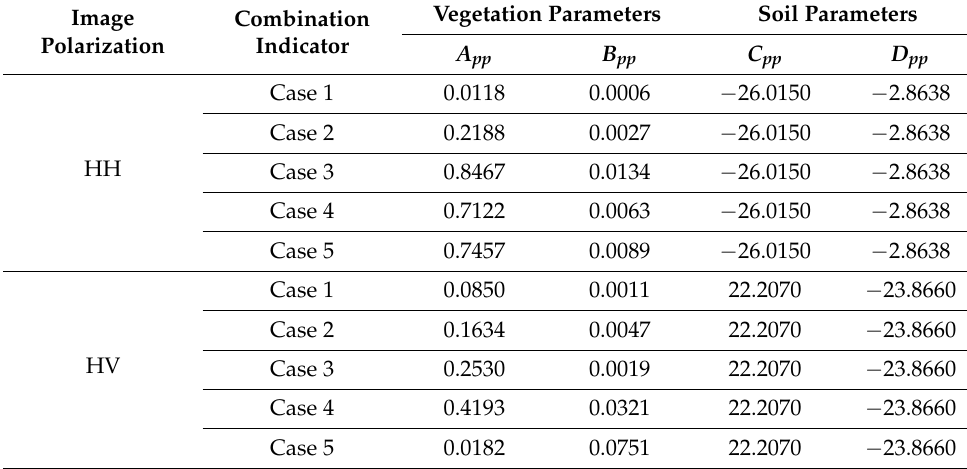
Table 4. WCM PALSAR-2 polarization calibration parameters for oil palm trees and combination vegetation descriptors used in this